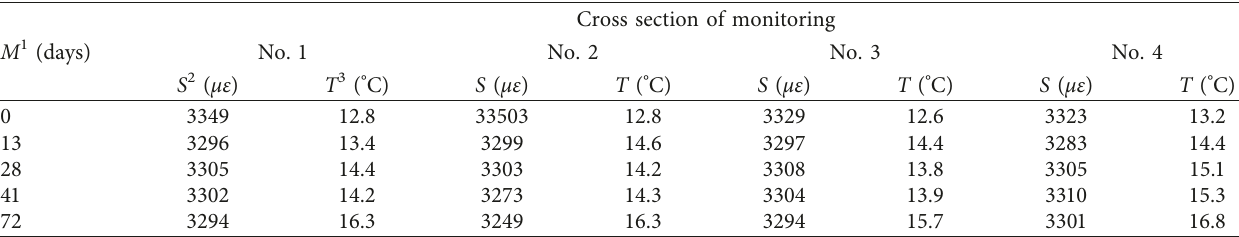
Figure 10: Time history of the acceleration of the observation point: (a) horizontal direction and (b) vertical direction. Table 3: Outputs of the field